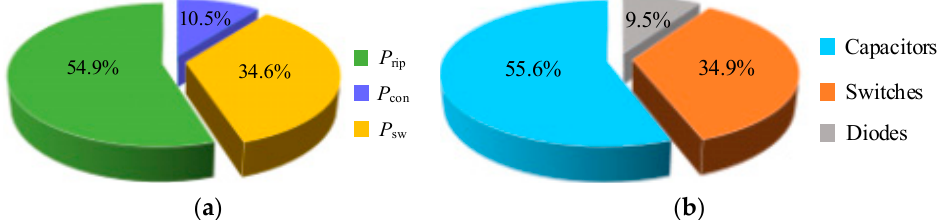
Figure 22. Losses distribution. ( a ) The ratio between the three types of losses. ( b ) The ratio between three types of devices.